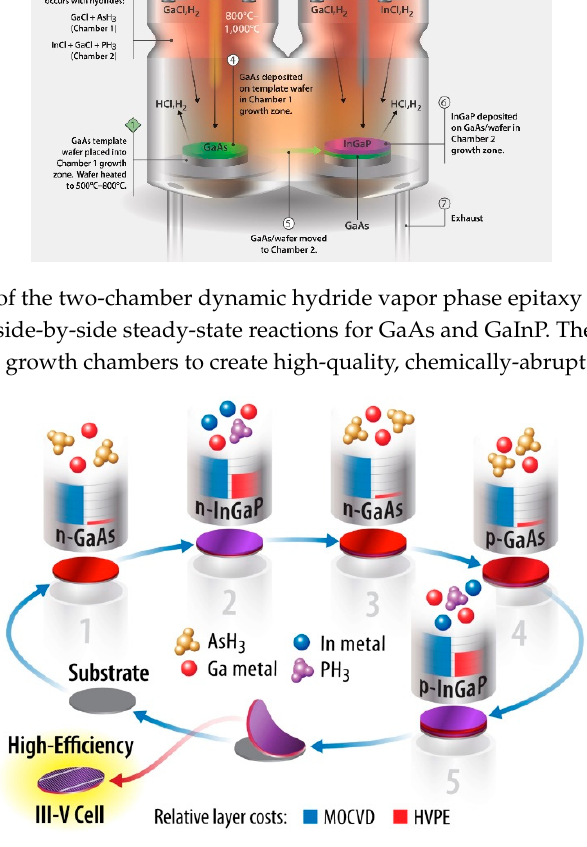
Figure 2. Schematic of the in-line HVPE reactor used to grow low-cost single junction GaAs solar cells, together with a substrate reuse technology.